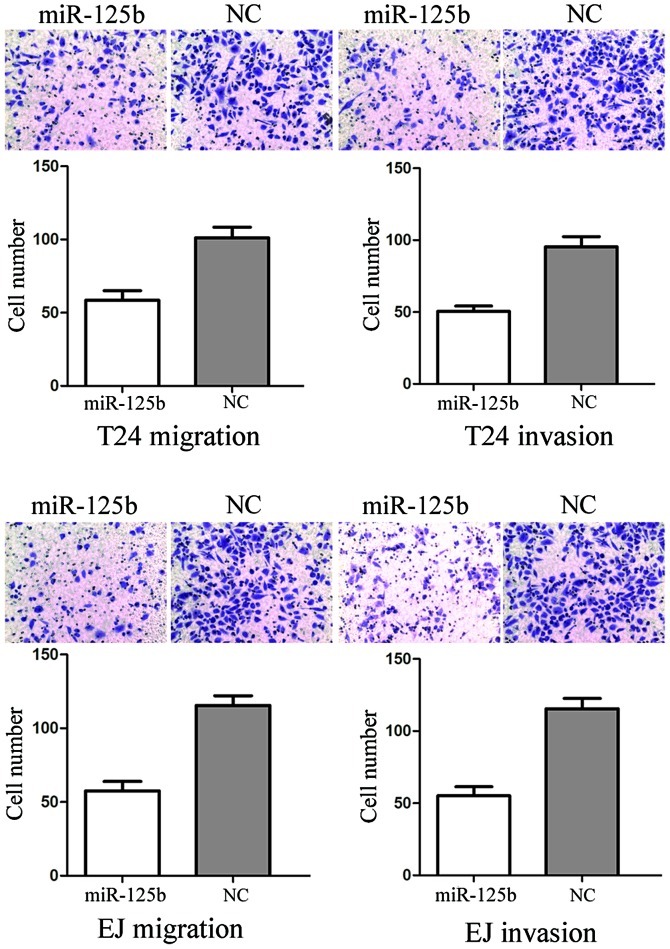
miR-125b inhibition of cell migration and invasion. Representative photos and statistical plots of migration and invasion assays in bladder cancer T24 and EJ cells. Following 12 h incubation, the number of T24 and EJ cells that transversed the Transwell membrane decreased after the transfection of miR-125b, compared with the controls (Student’s t-test, P<0.05). Following 24 h of incubation, the number of T24 and EJ cells that transversed the Transwell membrane pre-coated with Matrigel also decreased after the transfection of miR-125b, compared with the controls (Student’s t-test, P<0.05). miR-125b, microRNA-125b; NC, scrambled control.